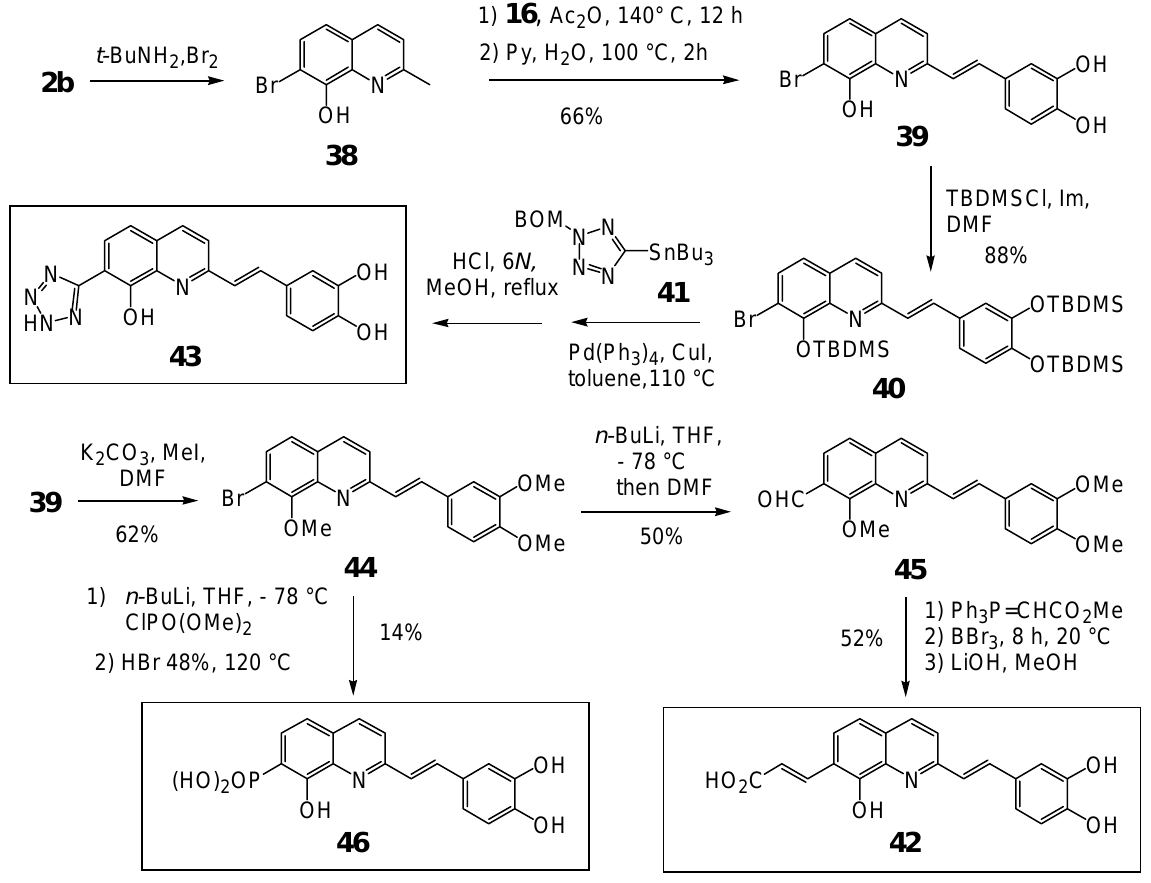
Scheme 4. Synthesis of C7-modified styrylquinolines 42, 43 and 46